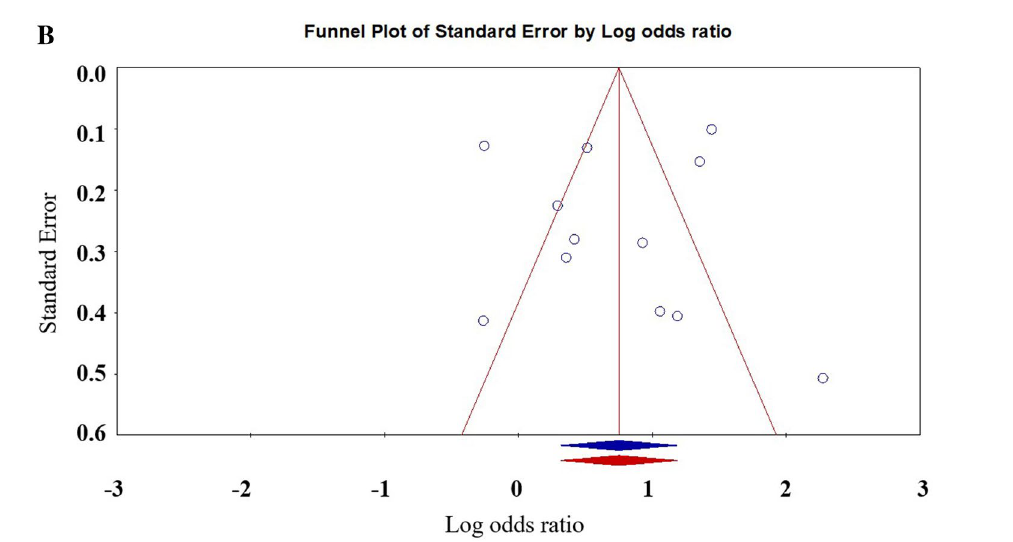
Figure 4. Forest plot for the effect size comparing the NSSI of bullies with children not involved in bullying.